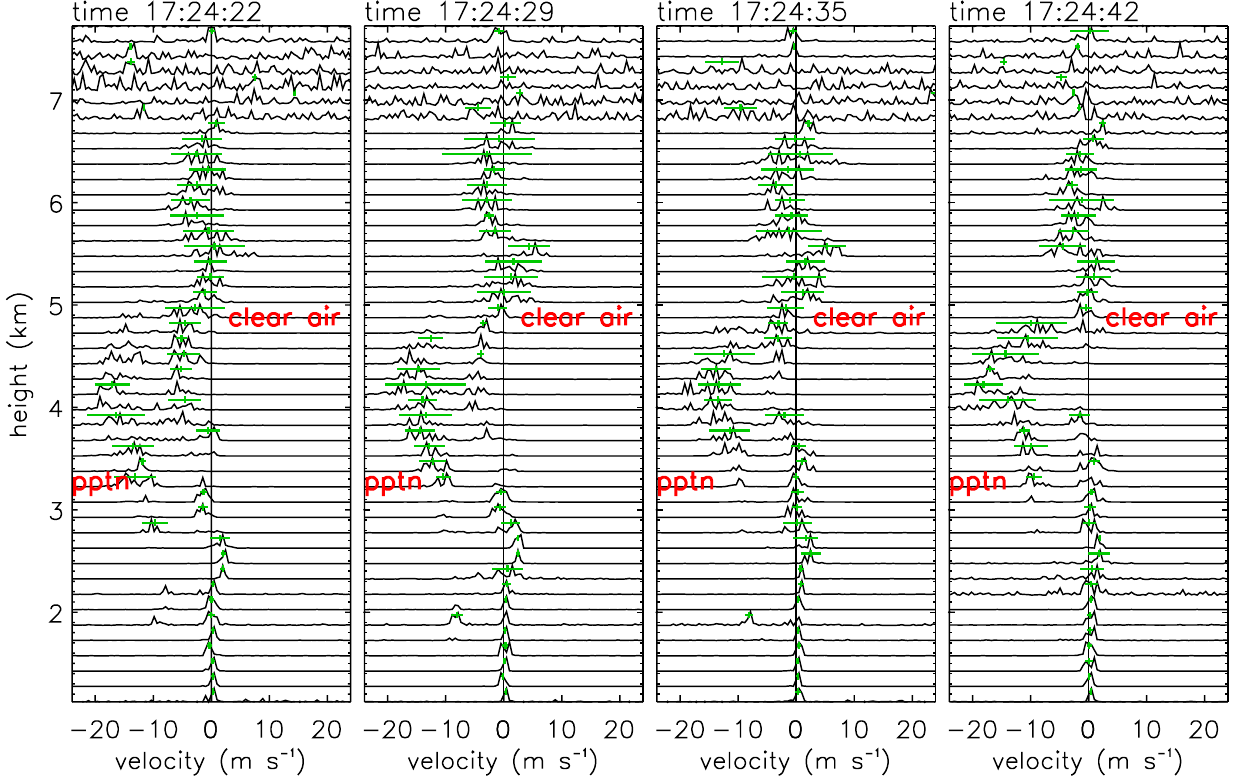
Fig. 12. Vertical-beam Doppler spectra for plots 81–84 of Figs. 11(b, c, d). Green lines show Doppler shift and spectral width of most powerful echo at each range gate, usually clear air or precipitation.